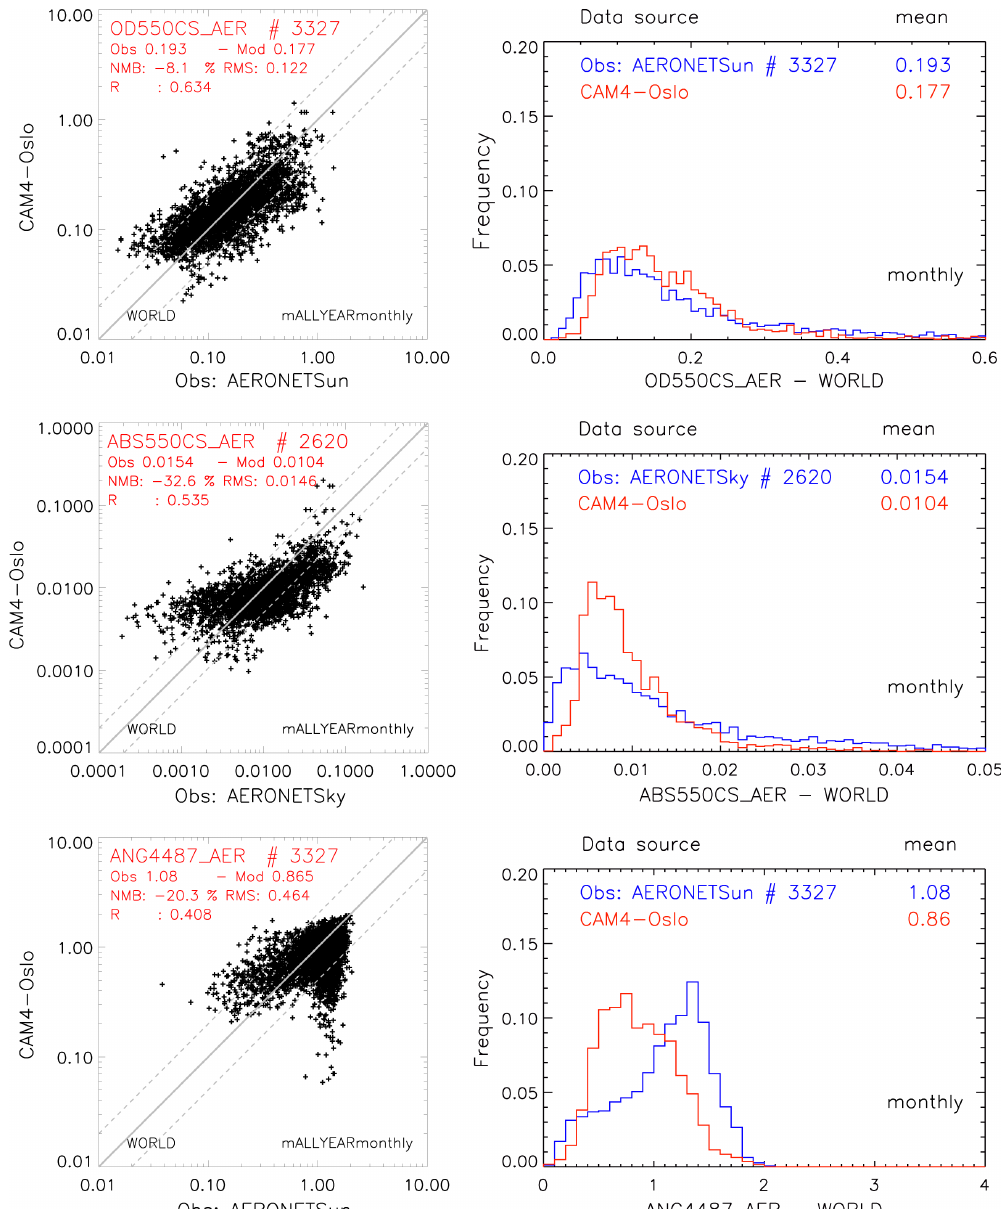
Fig. 9. Model-calculatedvs.retrieved aerosol optics data from AERONET, shown as scatterplots (left) and frequency histograms (right). Up- per row: modeled clear-sky AOD at wavelength 550nmvs.AERONET. Middle row: modeled clear-sky ABS (absorption AOD) at wavelength 550nmvs.AERONET ABS. Lower row: ANG ( ˚Angstr¨om parameter) calculated from all-sky AOD at 440 and 870nm. The AERONET re- trievals are from the period 2000–2009, and are made available through the AeroCom